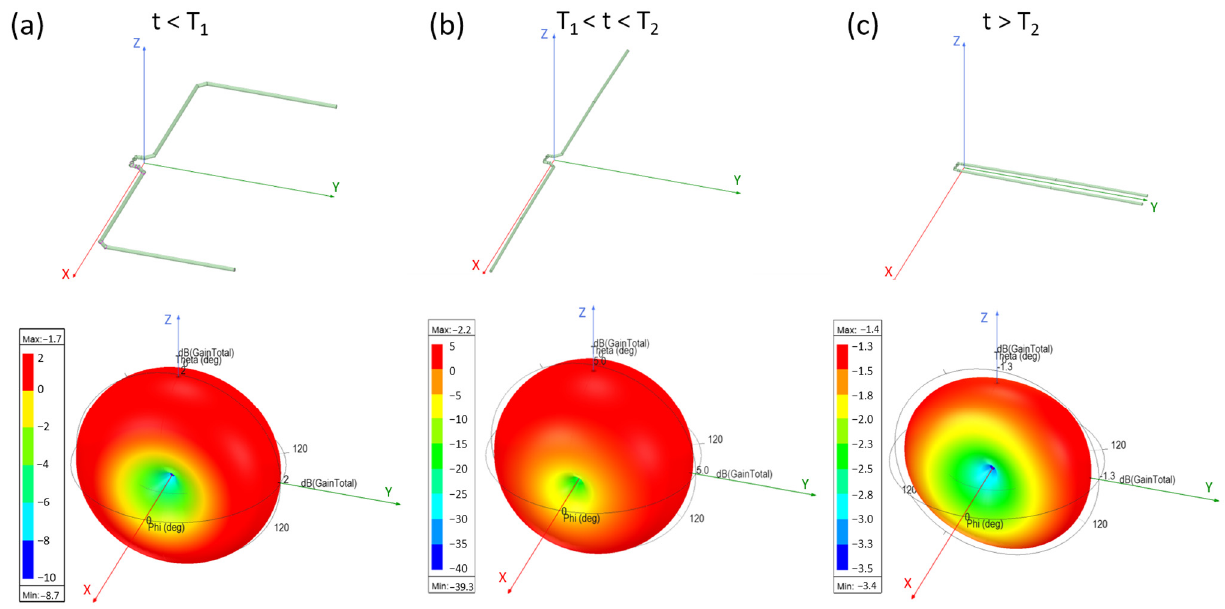
Figure 4. Simulated 3D radiation pattern of the ShMoA and corresponding antenna geometry at ( a ) t < T 1 , ( b ) T 1 < t < T 2 , and ( c ) t > T 2 .